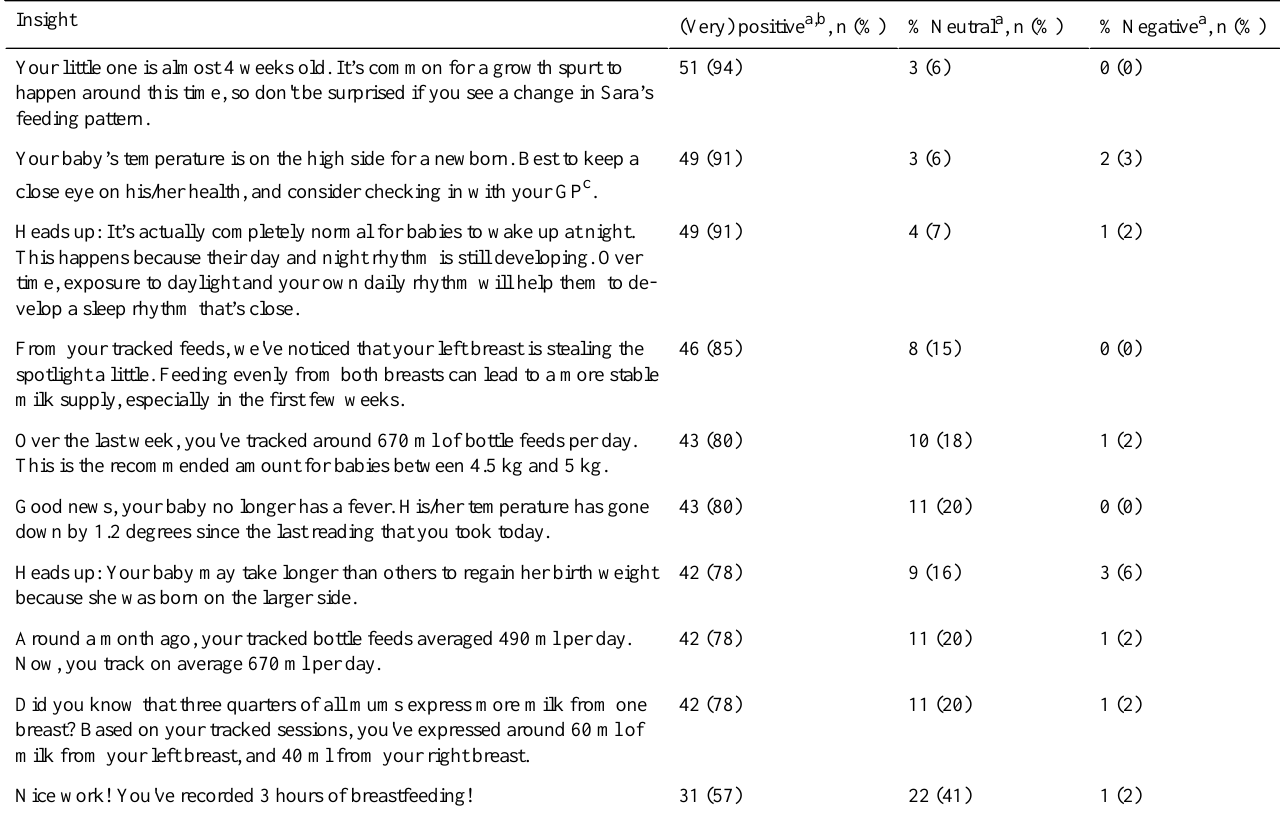
Table 3. Participants’evaluation of individual insights